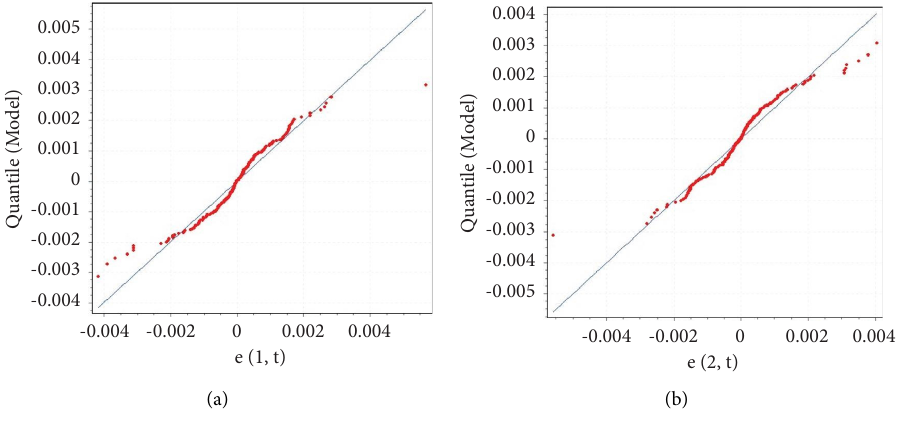
Figure 3: Q - Q plots of e